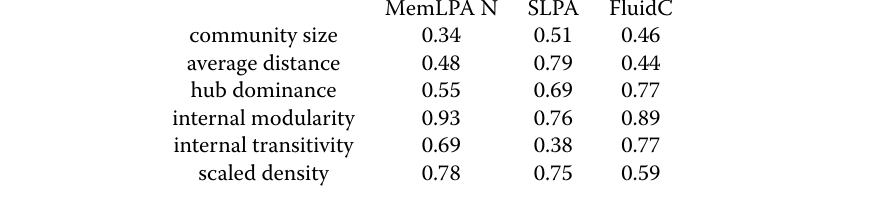
Fig. 8 Experiments on the LFR benchmark. N: node preference. Experiments are run 500 times and results averaged on communities having same size. The KS distance between the ground truth and communities found is shown in the table